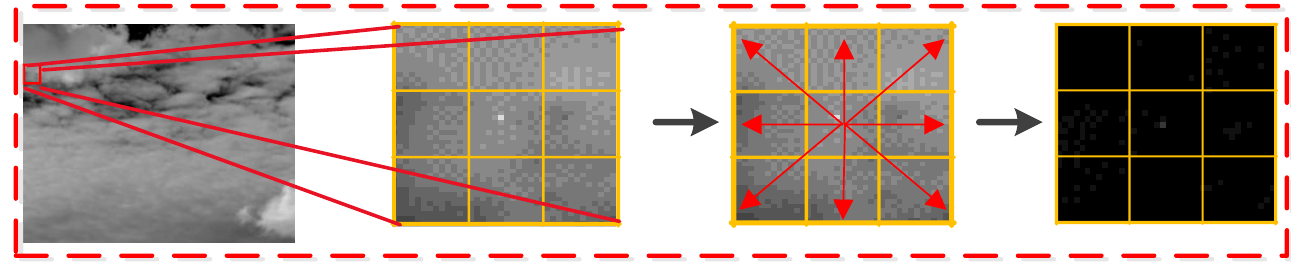
Figure 1. Details of the constructed local gradient